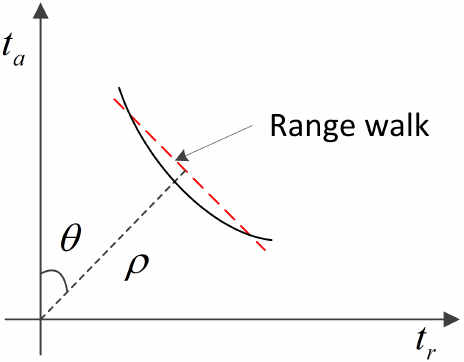
Figure 2. Hough transform schematic (the red line is the estimated range walk, and the black curve is the real range